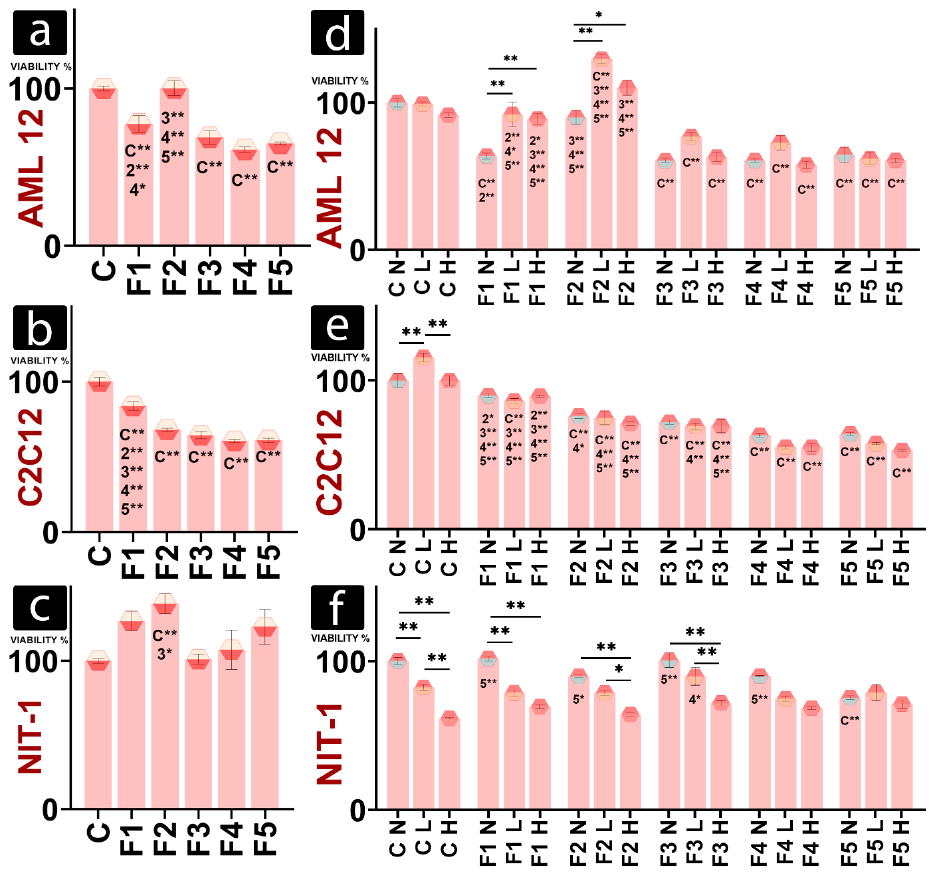
Figure 3. Viability of AML12 ( a ), C2C12 ( b ), and NIT-1 ( c ) under normal conditions. Viability of hepatic ( d ), muscle ( e ), and pancreatic beta cells ( f ) under different hypoxic conditions, where N, non-hypoxic control environment; L, lower hypoxic environment; and H, higher hypoxic environment. p < 0.01 (*) or p < 0.05 (**).